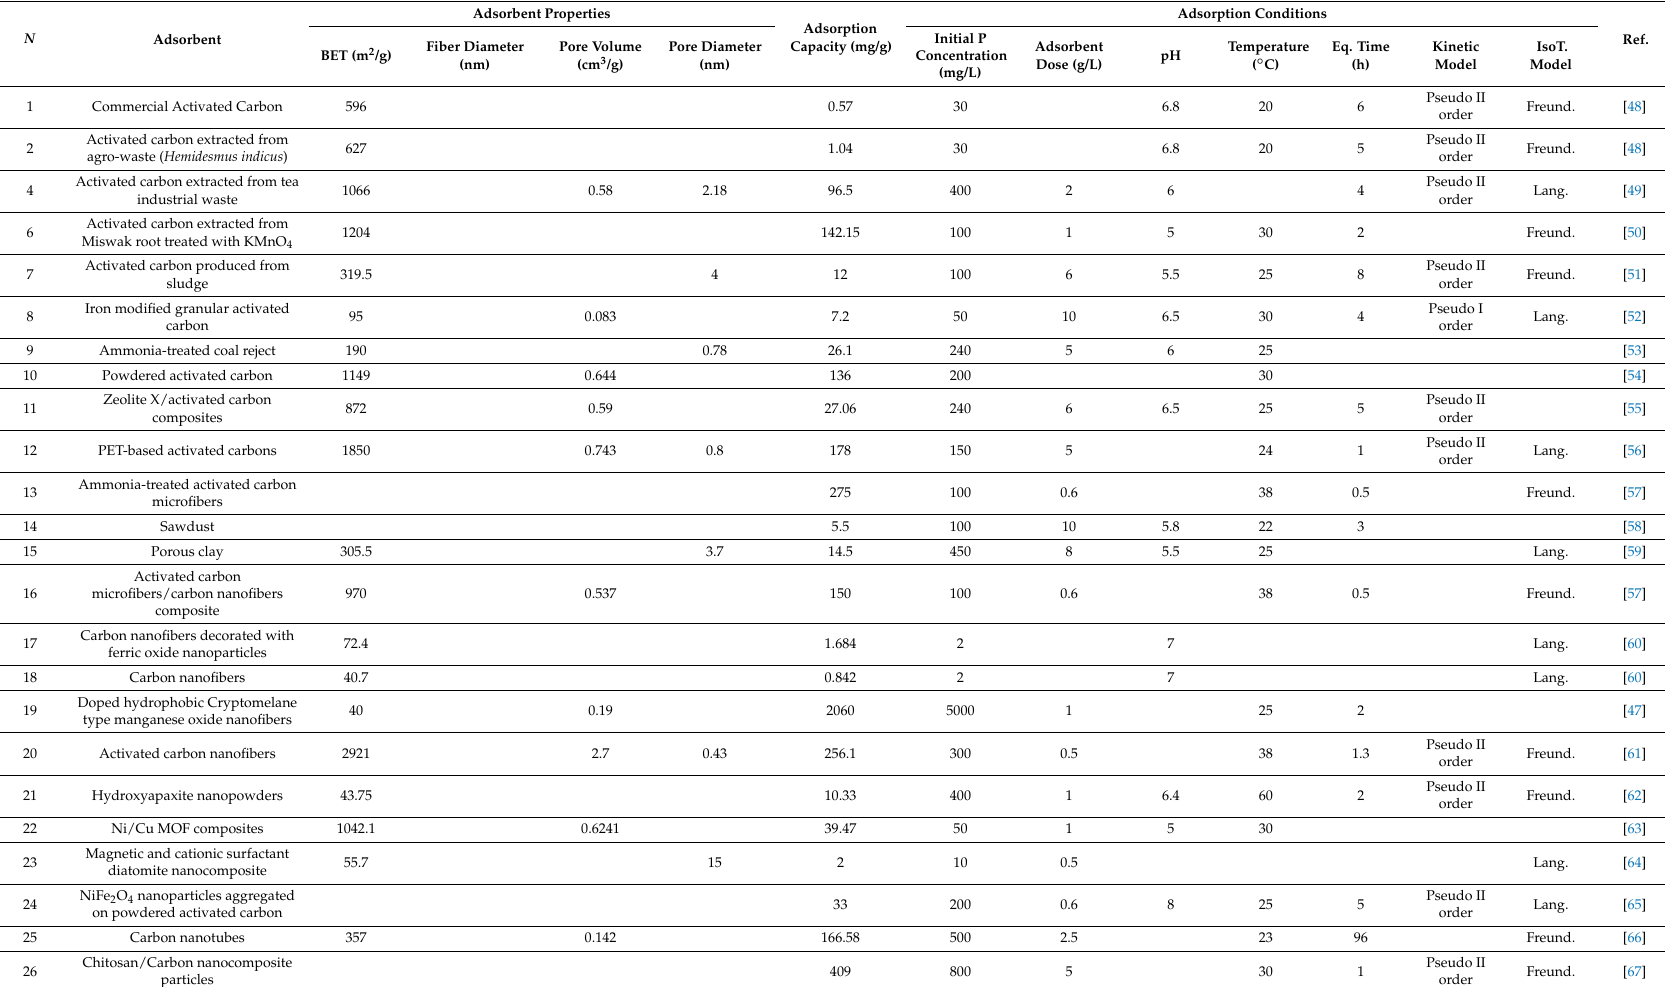
Table 7. Nanofibrous adsorbent properties and adsorption conditions for the removal of